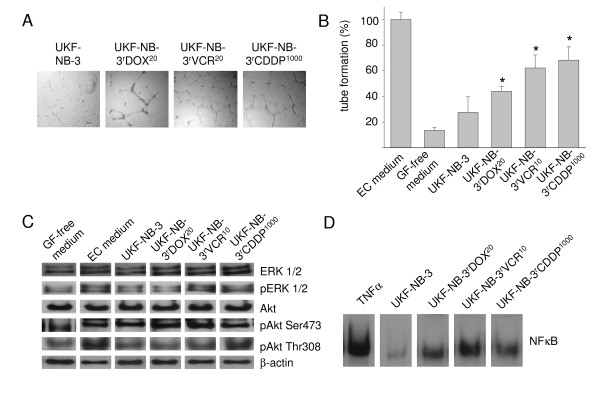
Influence of neuroblastoma cell culture supernatants on tube formation and activation of pro-angiogenic signalling pathways in endothelial cells. A) Representative photographs showing tube formation of human umbilical vein endothelial cells (HUVECs) suspended in 1:1 mixtures of IMDM + 10 FCS and supernatants of parental chemosensitive UKF-NB-3 cells or sublines adapted to vincristine (UKF-NB-3rVCR10), cisplatin (UKF-NB-3rCDDP1000), or doxorubicin (UKF-NB-3rDOX20) 16 h after seeding on extracellular matrix. B) Quantification of tube formation by counting of branching points of HUVEC incubated with 1:1 mixtures of IMDM and supernatants of UKF-NB-3, UKF-NB-3rVCR10, UKF-NB-3rCDDP1000, or UKF-NB-3rDOX20 cells + 10% FCS in comparison to endothelial cell medium (EC medium, IMDM + 15% FCS + 5% pooled human serum + bFGF 2.5 ng/ml) and growth factor-free medium (GF-free medium, IMDM + 10% FCS). P < 0.05 relative to endothelial cells incubated with UKF-NB-3 supernatants. C) Representative Western blot showing expression of ERK 1/2, phosphorylated ERK 1/2 (pERK 1/2), Akt, Akt phosphorylated at Ser473 (pAkt Ser473), or Akt phosphorylated at Thr308 (pAkt Thr308) in endothelial cells incubated with 1:1 mixtures of IMDM and supernatants of UKF-NB-3, UKF-NB-3rVCR10, UKF-NB-3rCDDP1000, or UKF-NB-3rDOX20 cells + 10% FCS in comparison to EC medium and GF-free medium for 24 h. β-actin was used as loading control. D) Representative EMSA showing nuclear factor κB (NFκB) activation in endothelial cells incubated with 1:1 mixtures of IMDM and supernatants of UKF-NB-3, UKF-NB-3rVCR10, UKF-NB-3rCDDP1000, or UKF-NB-3rDOX20 cells + 10% FCS for 24 h. Tumour necrosis factor α (TNFα) was used as positive control.